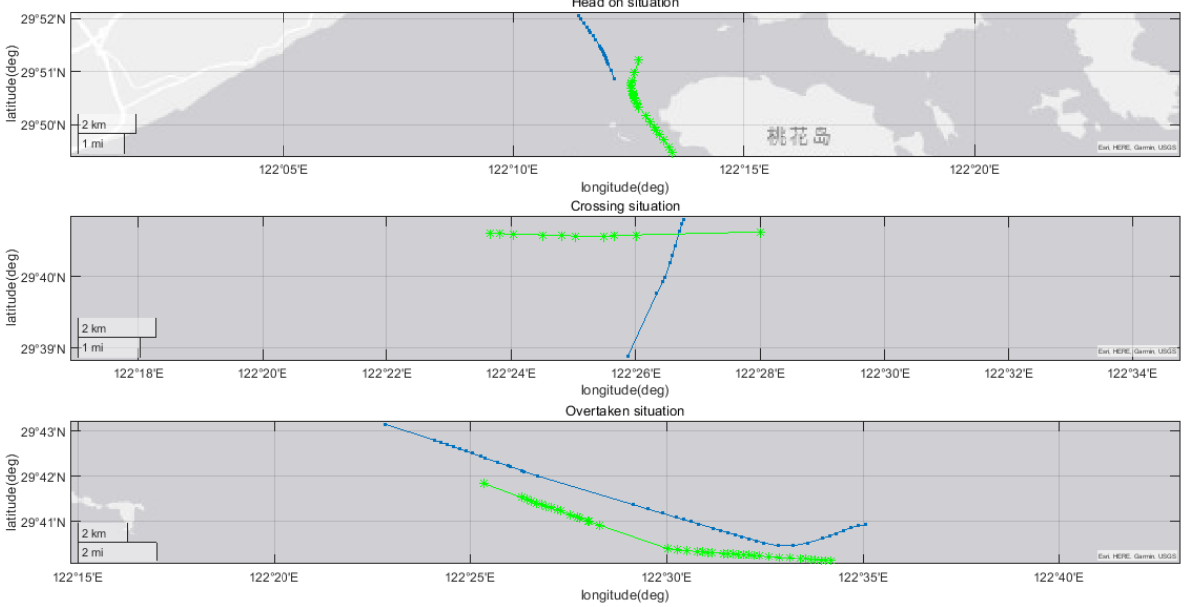
Figure 10. Ships encounter relationships based on the coordinates of vessels. Figure 11. Ship encounter situation identification results.